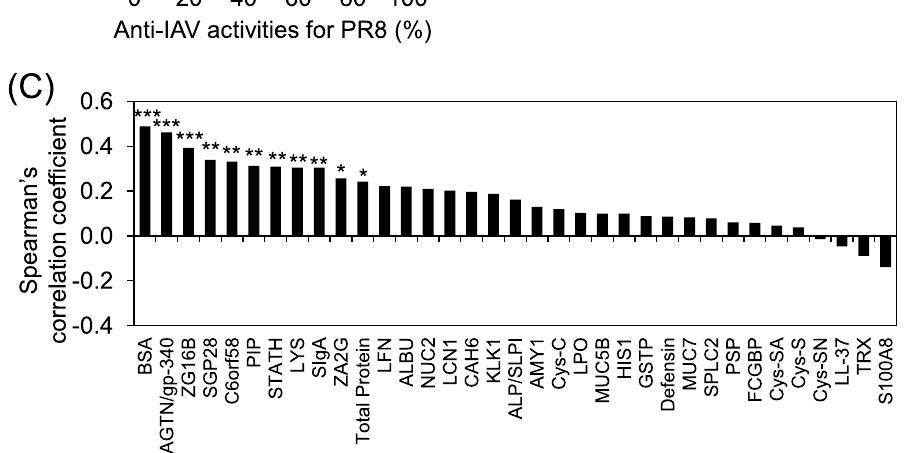
Figure 2. Individual differences of salivary anti-IAV activities. ( A ) Salivary anti-IAV activities against PR8 IAV strain (n = 92). Data are presented as mean ± SD from three independent experiments. A bar graph shows the activity in each subject. ( B ) Correlation between salivary anti-IAV activity against PR8 and Memphis IAV strains (n = 65). The plot shows significant moderate positive correlation. ( C ) The correlation between salivary anti-IAV activity against the PR8 IAV strain and amount of various salivary components (n = 72–85). A bar graph shows Spearman’s correlation coefficient (ρ) in each subject. * p < 0.05; ** p < 0.01; *** p <